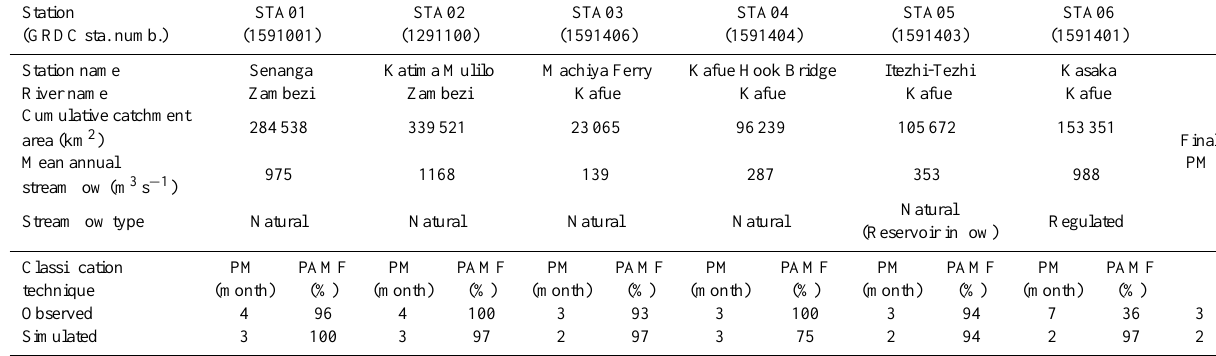
Table 4. Comparison of peak month (PM) for flooding and calculated P AMF at six GRDC stations in the Zambezi River basin.